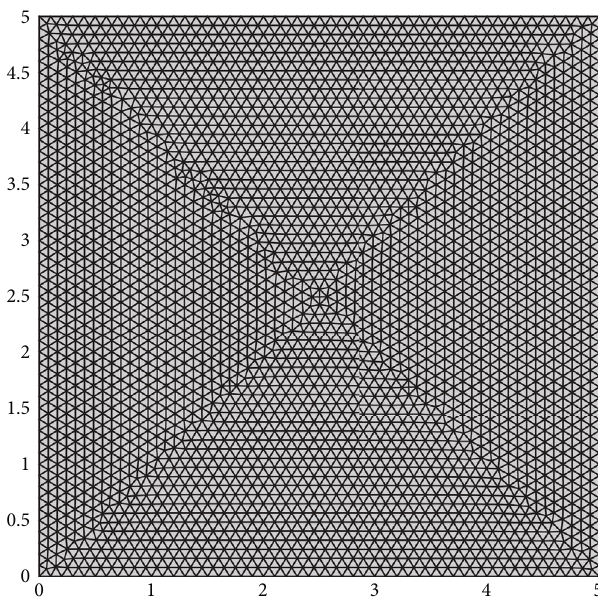
Figure 2: Mesh discretization of the simulation domain. Table 1: Parameters for the numerical